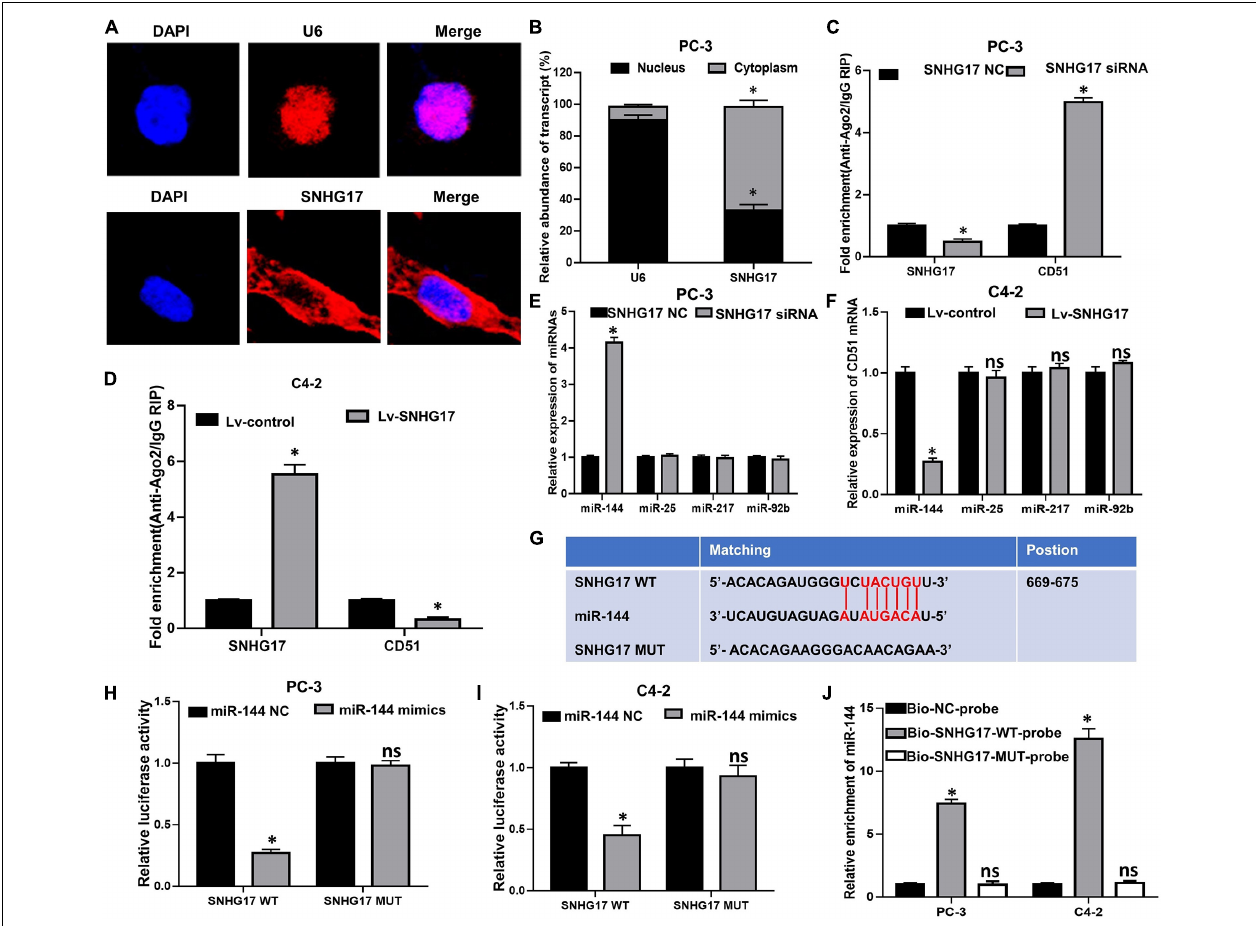
FIGURE 6 | SNHG17 directly sponge miR-144 in CRPC cells. (A) Subcellular localization of SNHG17 in PC-3 cells, detected by FISH; Blue: DAPI, Red: CY3-SNHG17-probe. U6 was used as a nuclear marker; (B) Subcellular localization of SNHG17 in PC-3 cells, as detected by RT-QPCR. U6 was used as a nucleus marker; (C,D) Enrichment of SNHG17 and CD51 in Ago2 containing beads, detected in PC-3 (D) and C4-2 (E) cells by Ago2-RIP; (E,F) Effects of SNHG17 on the expression of miRNAs with putative binding sites for SNHG17 in PC-3 (E) and C4-2 (F) cells; (G) miR-144 WT and MUT targeting region of SNHG17; (H,I) Relative luciferase activity of PC-3 (H) and C4-2 (I) cells co-transfected with WT/MUT SNHG17 plasmid and miR-144 NC/mimics; (J) Enrichment of miR-144 in the sample pulled down by Bio-SNHG17-probe, Bio-SNHG17-MUT-probe, and Bio-NC-probe; Data are expressed as the mean ± S.E . * P < 0.05, ns, not significant. The representative results of three independent experiments are